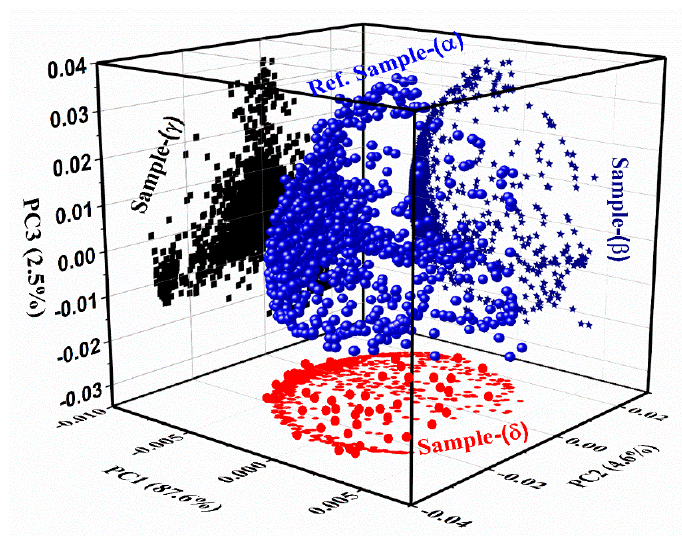
Figure 8. Clustering of the various P. harmala samples from the PCA scatter plot.